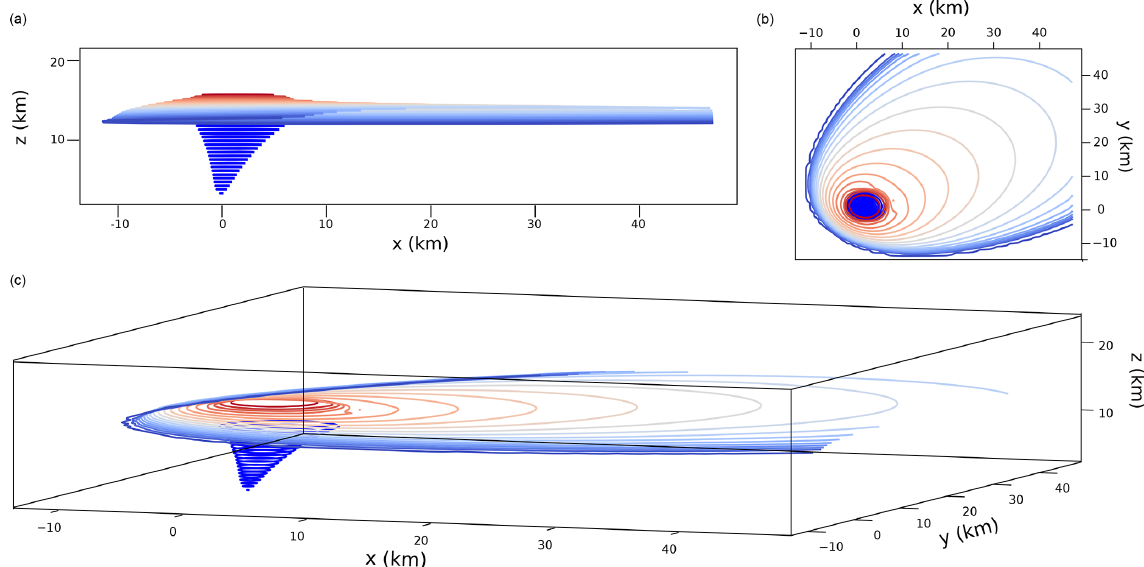
Figure 4. Lateral, top, and oblique views of the plume and the umbrella. The 3-D coordinate system ( x,y,z ) is centered horizontally at the plume base location and vertically at the sea level. Going up the neutral buoyancy level, the plume horizontal sections are calculated by the steady-state model. Above the neutral buoyancy level, the colored contours represent thickness levels of the steady solution computed by the transient umbrella model. The color is not meant to represent cloud thickness but only to better distinguish the contours. Table 1. Total grain size distribution for the April 2015 Calbuco eruption (Reckziegel et al., 2019). φ −